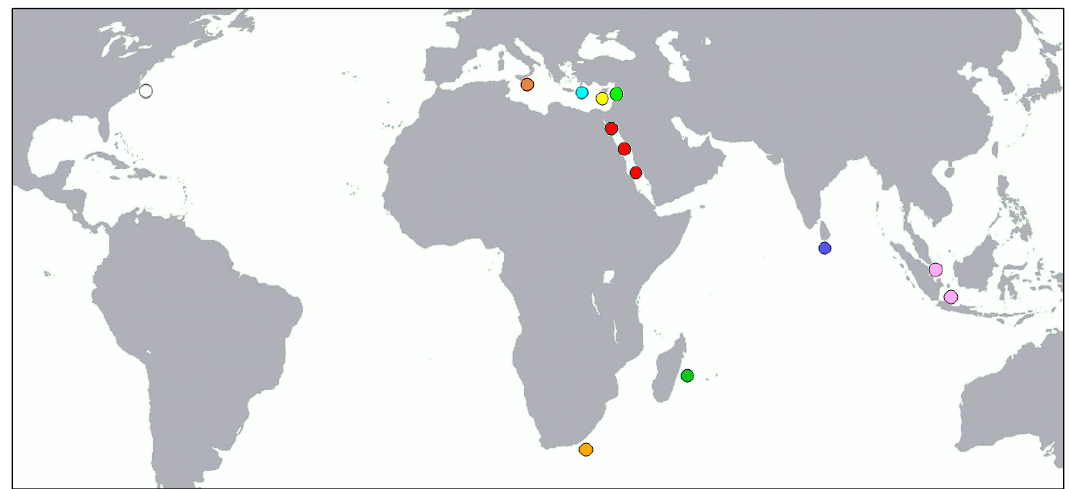
Figure 1. Localities of Pterois miles specimens included in our analyses. Colors correspond to Figures Figure1. Localitiesof Pteroismiles specimensincludedinouranalyses. 3 and 4.